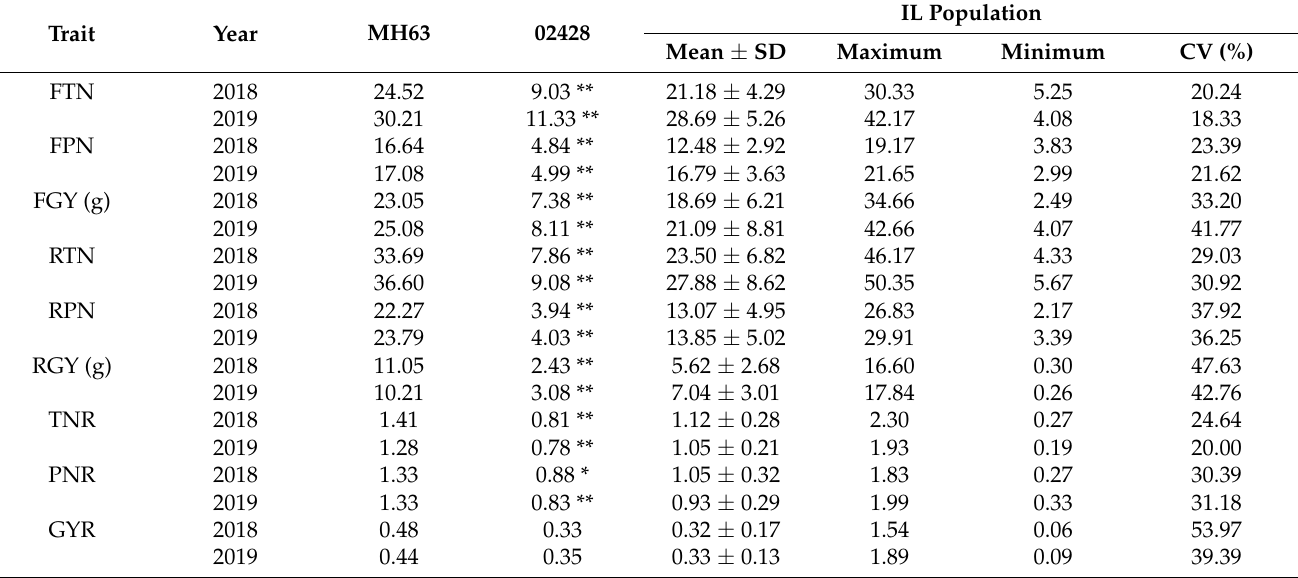
Table 1. Performance of ratooning-ability-related traits of the parents and their derived IL population. Trait